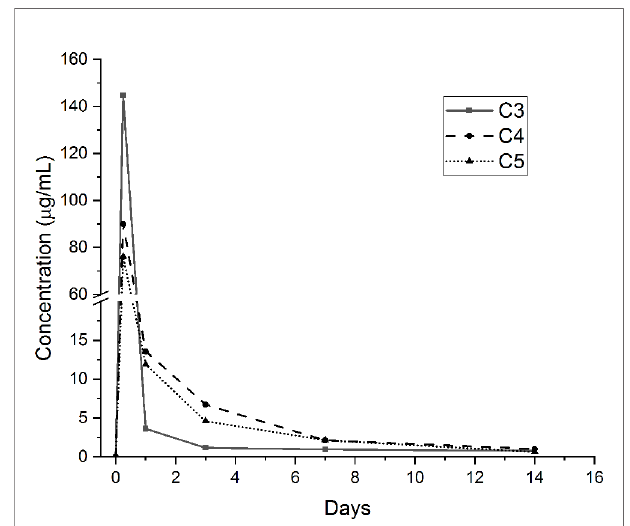
FIGURE 4 | Gentamicin (GS) release concentrations from GS-loaded agarose-coated